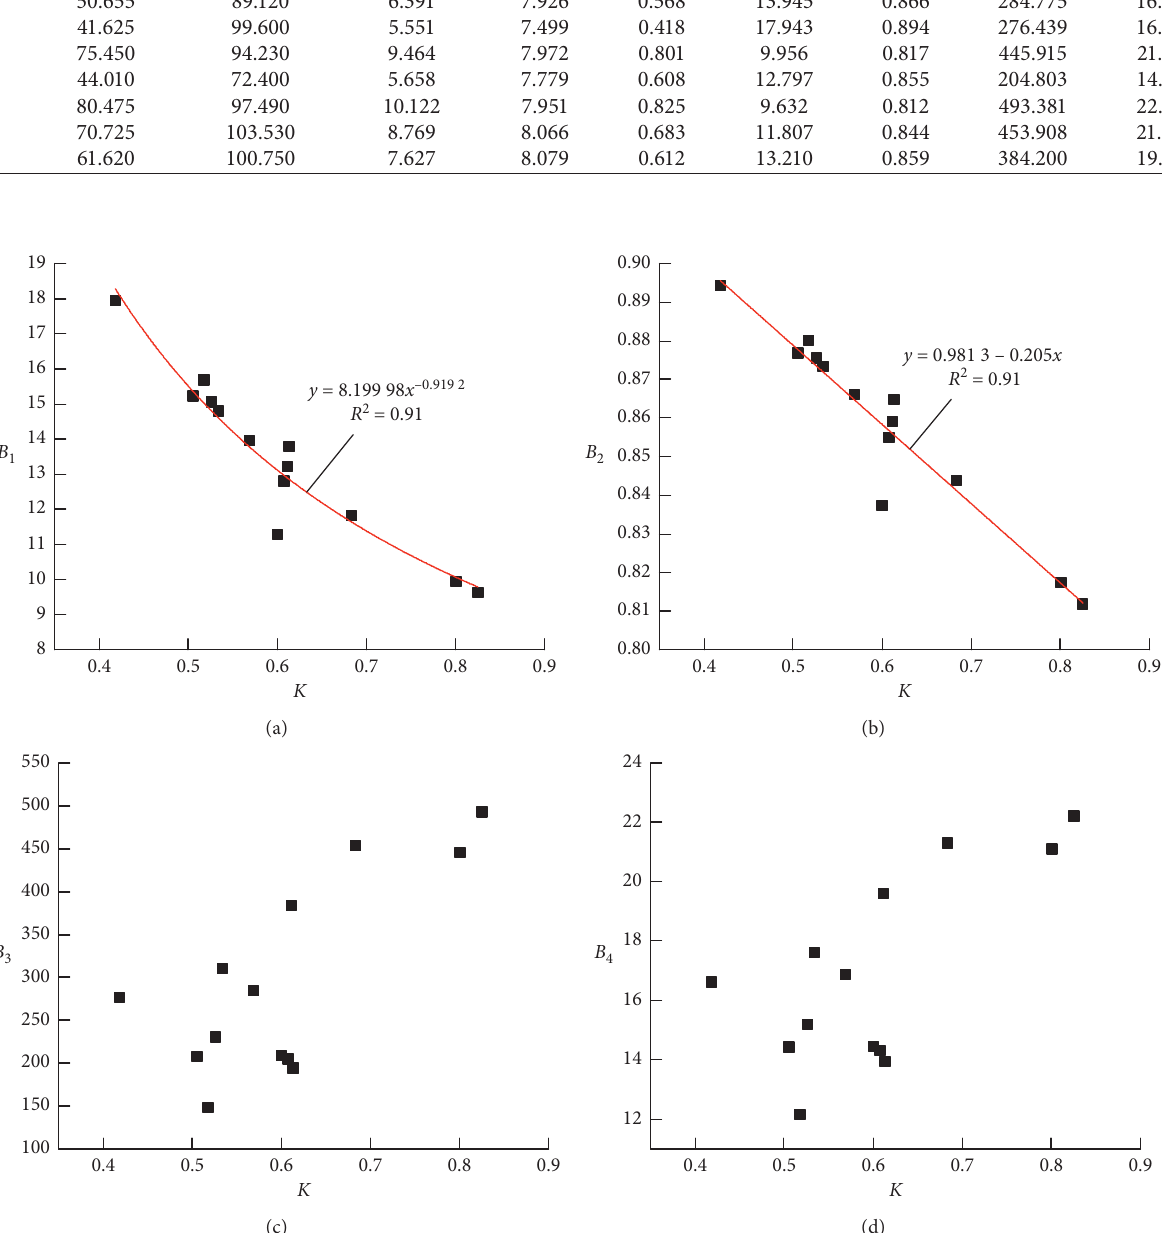
1 ; (b) B 2 ; (c) B 3 ; (d) B 4